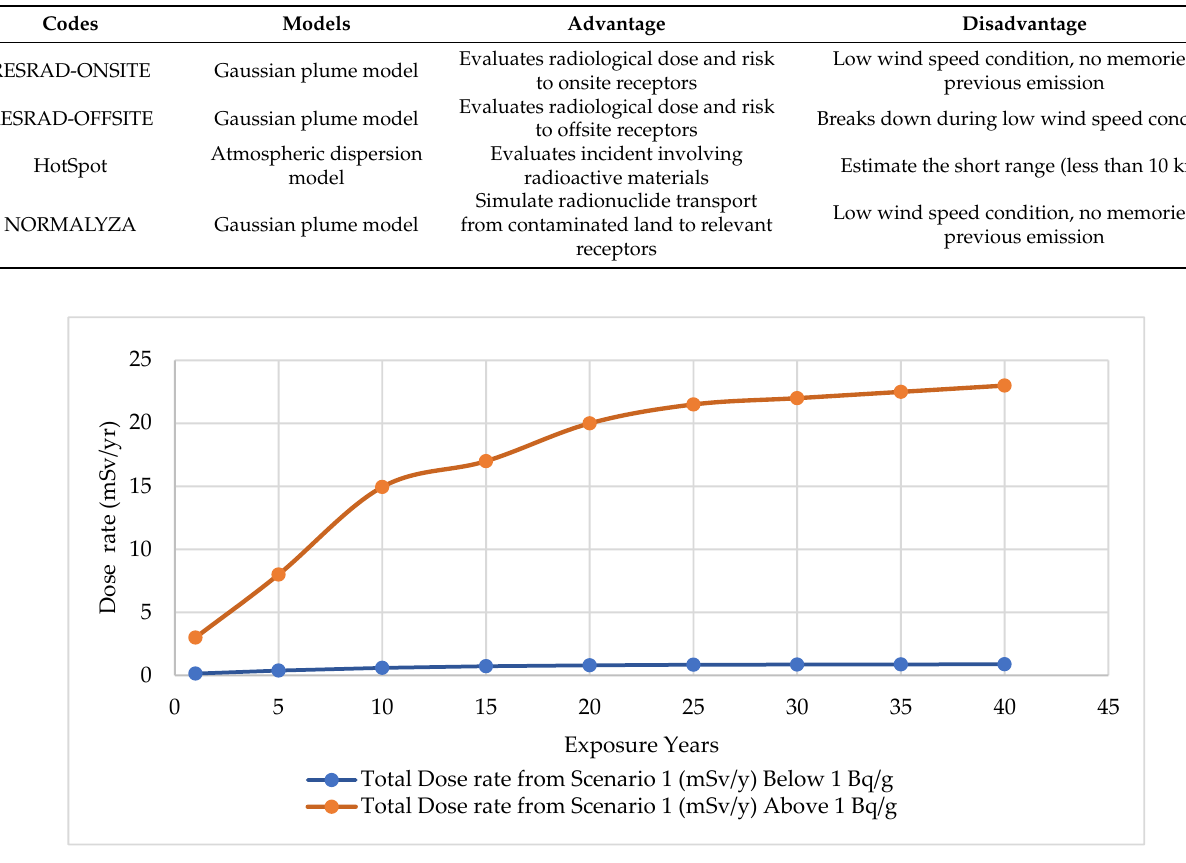
Figure 4. Results from RESRAD ONSITE scenario.